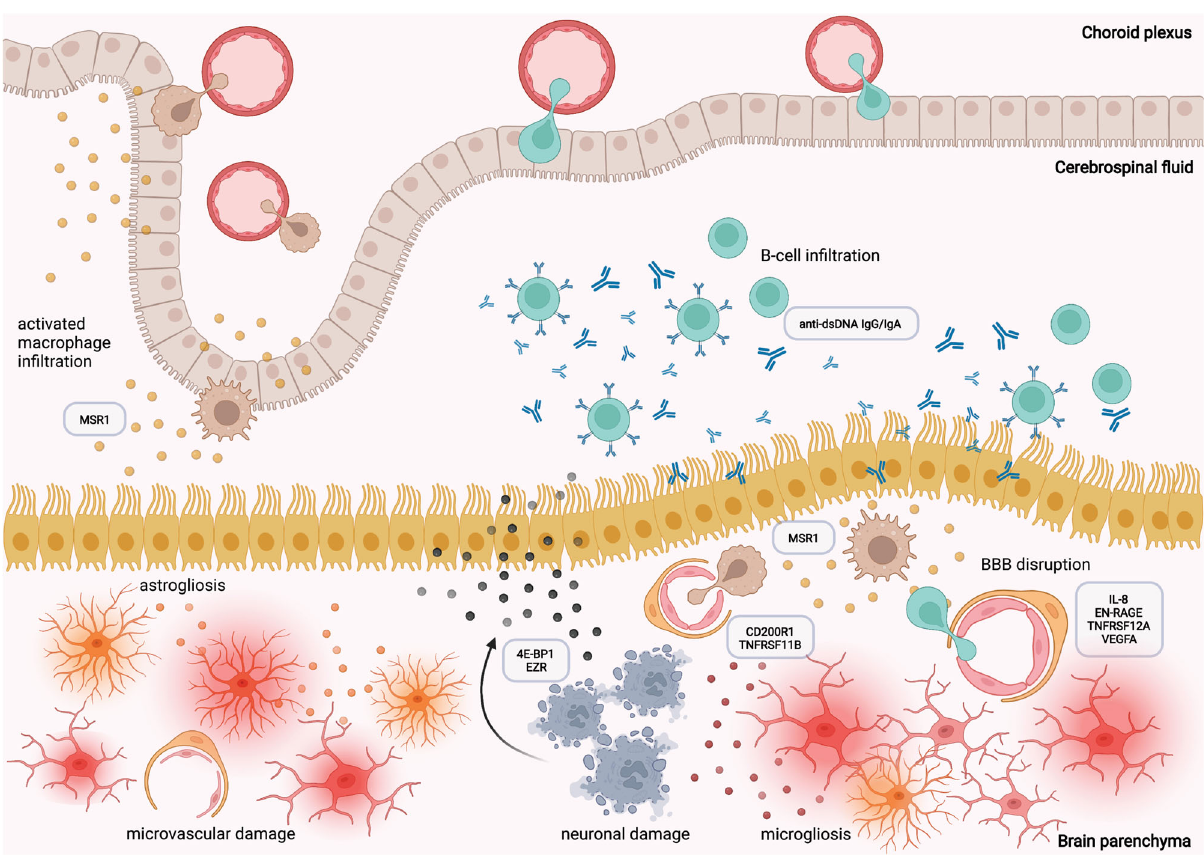
Fig. 9 | Overview of proposed pathomechanisms leading to Neuro-COVID. The proposed main determinants of severe Neuro-COVID are: (1) peripherally induced cytokinederangements,followed by(2)impairedBBBwithingressingpolyreactive